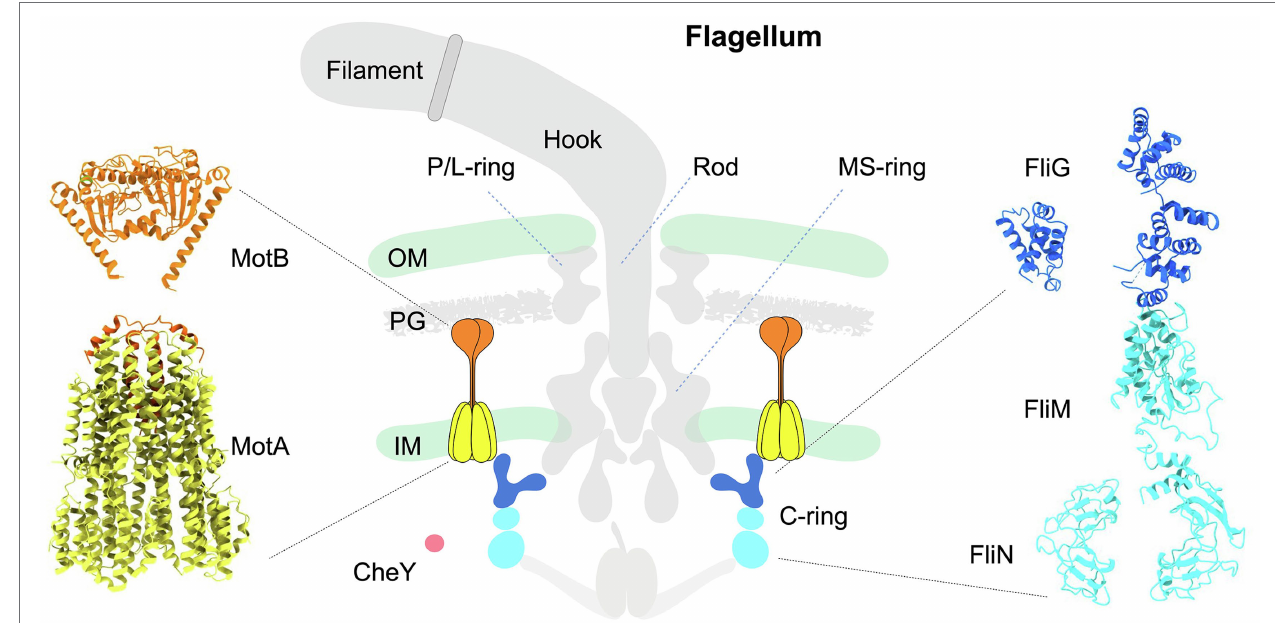
FIGURE 1 | Schematic diagram illustrating the architecture of the canonical flagellum from Escherichia coli . Middle panel: The flagellum is composed of the extracellular filament, a flexible hook, and a motor spanning the cell envelope. The motor is further composed of a central rotor surrounded by multiple stator units. The MS-ring is anchored in the inner membrane. Above the MS-ring are the P- and L-rings associated with the PG and outer membrane. Beneath the MS-ring is the C-ring (blue and cyan) in the cytoplasm. Each stator complex has two subunits: the pentameric cone-shaped MotA (yellow) is embedded in the inner membrane, and the extended MotB (orange) is anchored to the PG on one end, while its other end is inserted into MotA. CheY-like chemotactic signaling proteins are illustrated as a red sphere. OM: outer membrane. IM: inner membrane. PG: peptidoglycan. Left panel: Structure of a stator complex in its compact, inactive conformation. The structure of MotA (yellow) in complex with partial MotB (N-terminal helix, orange) from Campylobacter jejuni was resolved by cryo-EM single-particle analysis (PDB: 6ykm). The MotB PGB structure (C-terminal domain of MotB; orange) from Salmonella enterica was determined by X-ray crystallography (PDB: 2zvz). Right panel: Pseudoatomic structure of a C-ring subunit rotating in the CCW direction. The FliG subunit is colored blue, and the FliM/N subunits are colored cyan. The molecular models of individual C-ring proteins FliG, FliM, and FliN were generated with ITASSER using respective X-ray crystal structures as templates (PDBs of FliG domains: 4FHR, 3HJL; PDBs of FliM: 4FHR, 4YXB; PDB for FliN: 1YAB). Assembly of these proteins was guided by the C-ring architecture resolved by cryo-ET and subtomogram